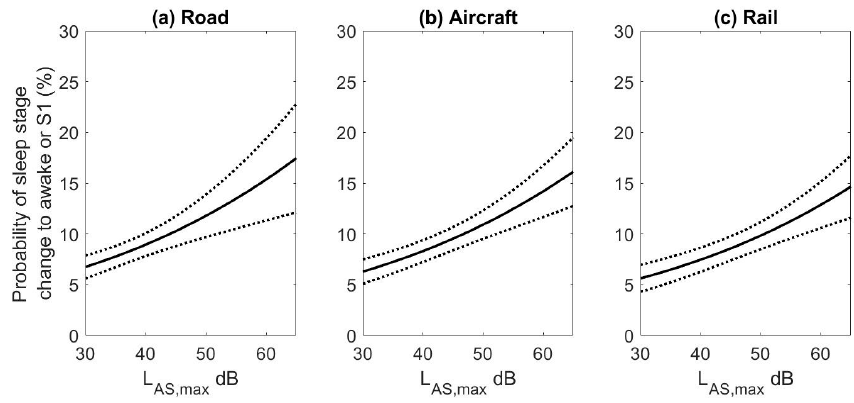
Figure 4. Probability of a sleep stage change to awake or S1 in a 90 s time window following noise event onset depending on the maximum indoor sound pressure level (L AS,max ) for ( a ) road (STRAIN and DEUFRAKO, N = 94 subjects); ( b ) aircraft (STRAIN, N = 61); and ( c ) rail noise (DEUFRAKO, N = 33). 95% confidence intervals (dashed lines). Results are for the unadjusted model.